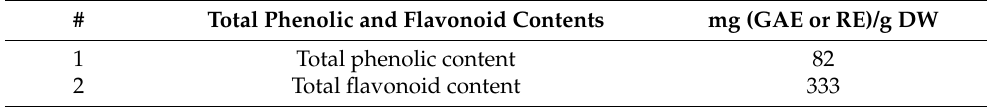
Table 2. Total phenolic and flavonoid contents of methanolic bark extract of Z. armatum